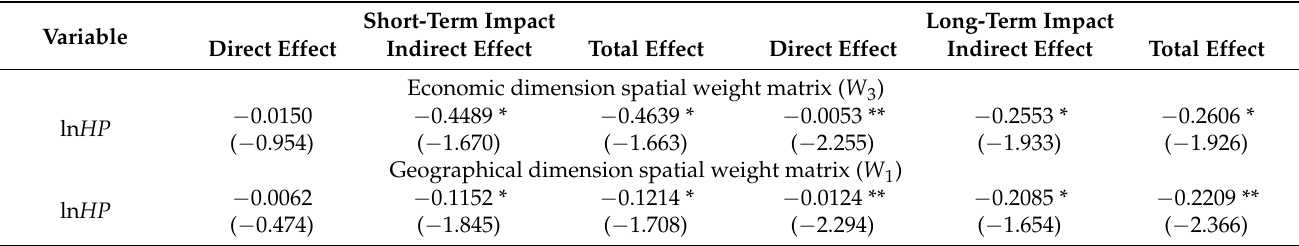
Table 7. Decomposition results of the impact of hydropower on haze pollution.